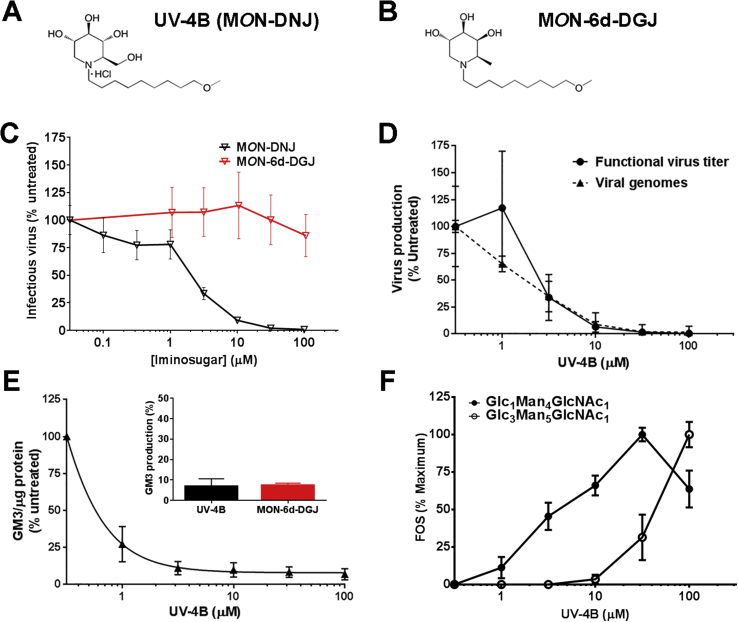
In vitro evaluation of iminosugar enzyme inhibition and antiviral activity using human monocyte-derived macrophages (MDMΦs). Chemical structure of (A) N-(9′-methoxynonyl)-1-deoxynojirimycin hydrochloride (UV-4B, MON-DNJ) and (B) N-(9′-methoxynonyl)-1,6-dideoxygalactonojirimycin (MON-6d-DGJ). (C-D) Primary human MDMΦs were infected with DENV2 strain 16681 at a multiplicity of infection of 1 and treated with a titration of iminosugar for 48 h. (C) Infectious virus titer was determined by plaque assay using LLC-MK2 (monkey kidney) cells. Cells from three donors were treated in triplicate and resulting samples quantitated using plaque assays in triplicate on each sample. Counts were normalized to 100% for untreated samples. Data are presented as mean ± SD. (D) Production of functional virus (quantitated using LLC-MK2 plaque assays) conducted on nine technical replicates was compared to total virus secreted (assessed using qRT-PCR conducted in technical duplicate) in untreated cells or cells treated with UV-4B. The values for both RNA and infectious virus are means normalized to untreated samples within a donor and a single representative donor is plotted as mean ± SD. (E) Uninfected human MDMΦs were treated with iminosugars for 48 h and glycolipids were isolated from whole cell lysates. Production of monosialodihexosylganglioside (GM3) was normalized to total protein content for each sample and each treatment was normalized to untreated controls on a donor specific basis. Inhibition of GM3 production by 100 μM of UV-4B (black) or 105 μM of MON-6d-DGJ (red) was assessed (inset) and a range of UV-4B concentrations. Data are presented as mean ± SD from assay of three biological replicates assayed in single sample. (F) MDMΦs were treated in technical duplicate for 48 h with iminosugar with a serial dilution of UV-4B or MON-6d-DGJ (not shown, results were negative) and inhibition of α-glucosidase I was measured by accumulation of Glc3Man5GlcNAc1 (white circles) while inhibition of α-glucosidase II was measured by accumulation of Glc1Man4GlcNAc1 (black circles). For each donor, the maximal concentration of each oligosaccharide species reached was normalized to 100%.